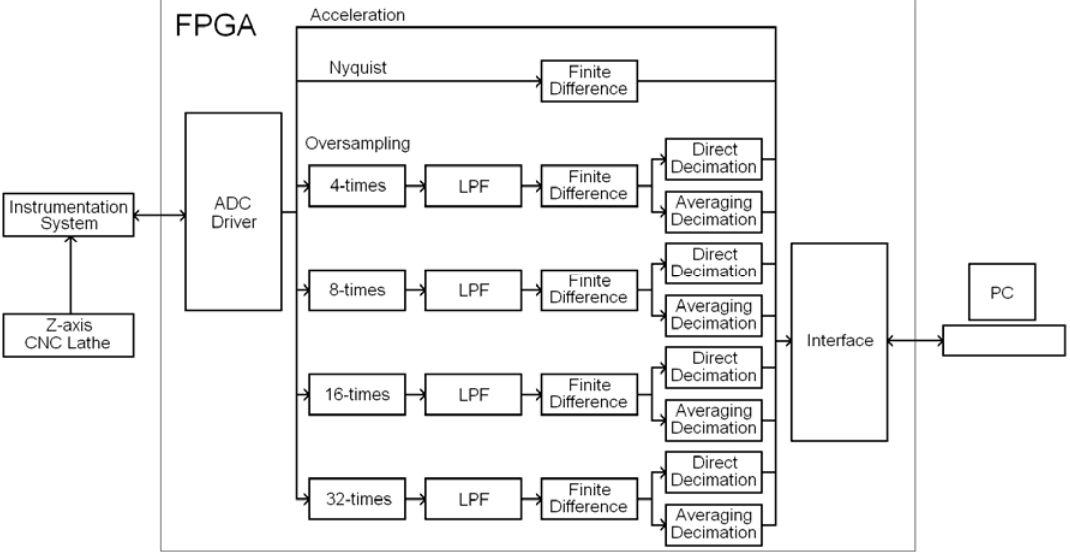
Figure 12. Block diagram of the FPGA-based signal processing unit.